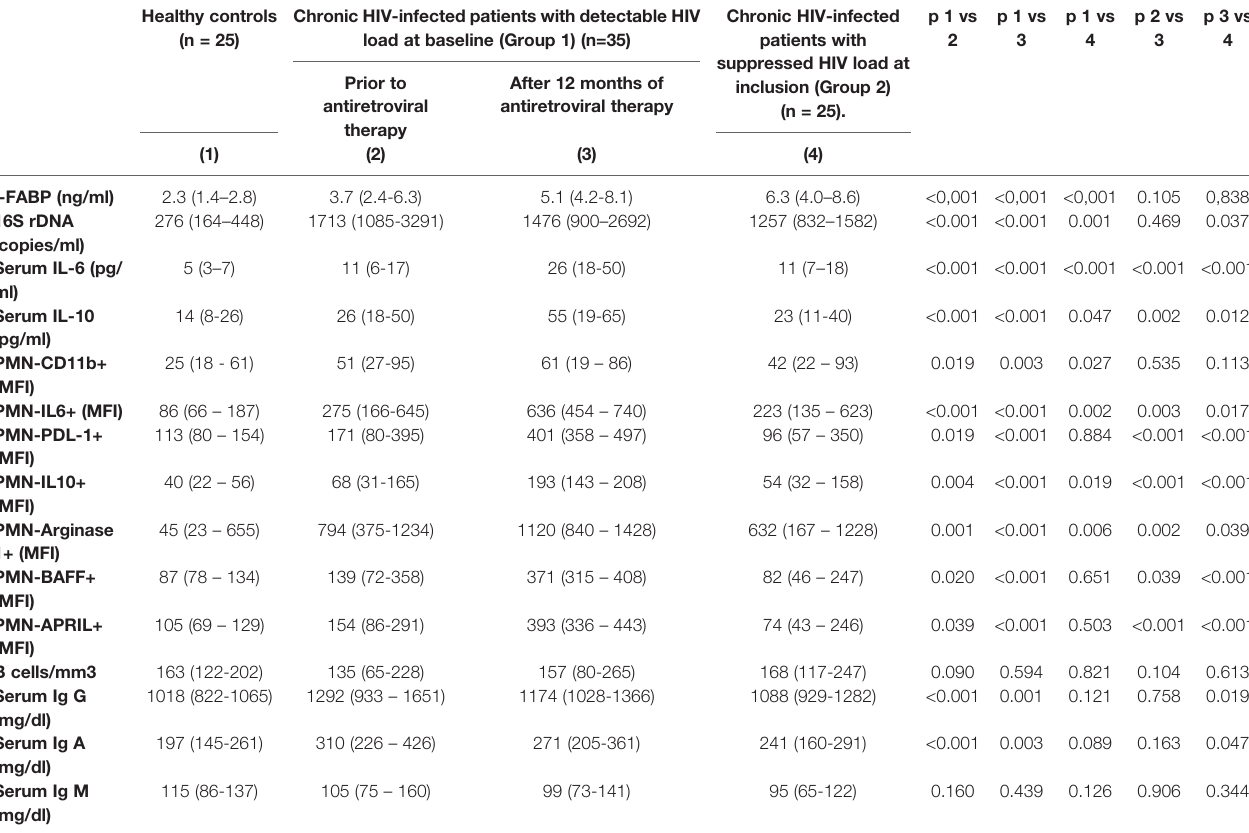
TABLE 2 | Gut barrier status, bacterial translocation and immune characteristics of healthy controls, patients with chronic infection, untreated at baseline, analyzed after 12 months of antiretroviral therapy, and of chronically treated HIV patients with undetectable HIV load at inclusion. Healthy controls Chronic HIV-infected patients with detectable HIV Chronic HIV-infected (n = 25) load at baseline (Group 1) (n=35) patients with suppressed HIV load at inclusion (Group